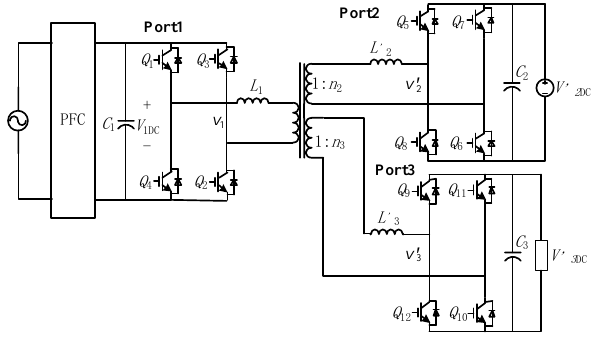
Figure 4. Three-port active bridge (TAB) for electric vehicles (EVs) as a combined charger.